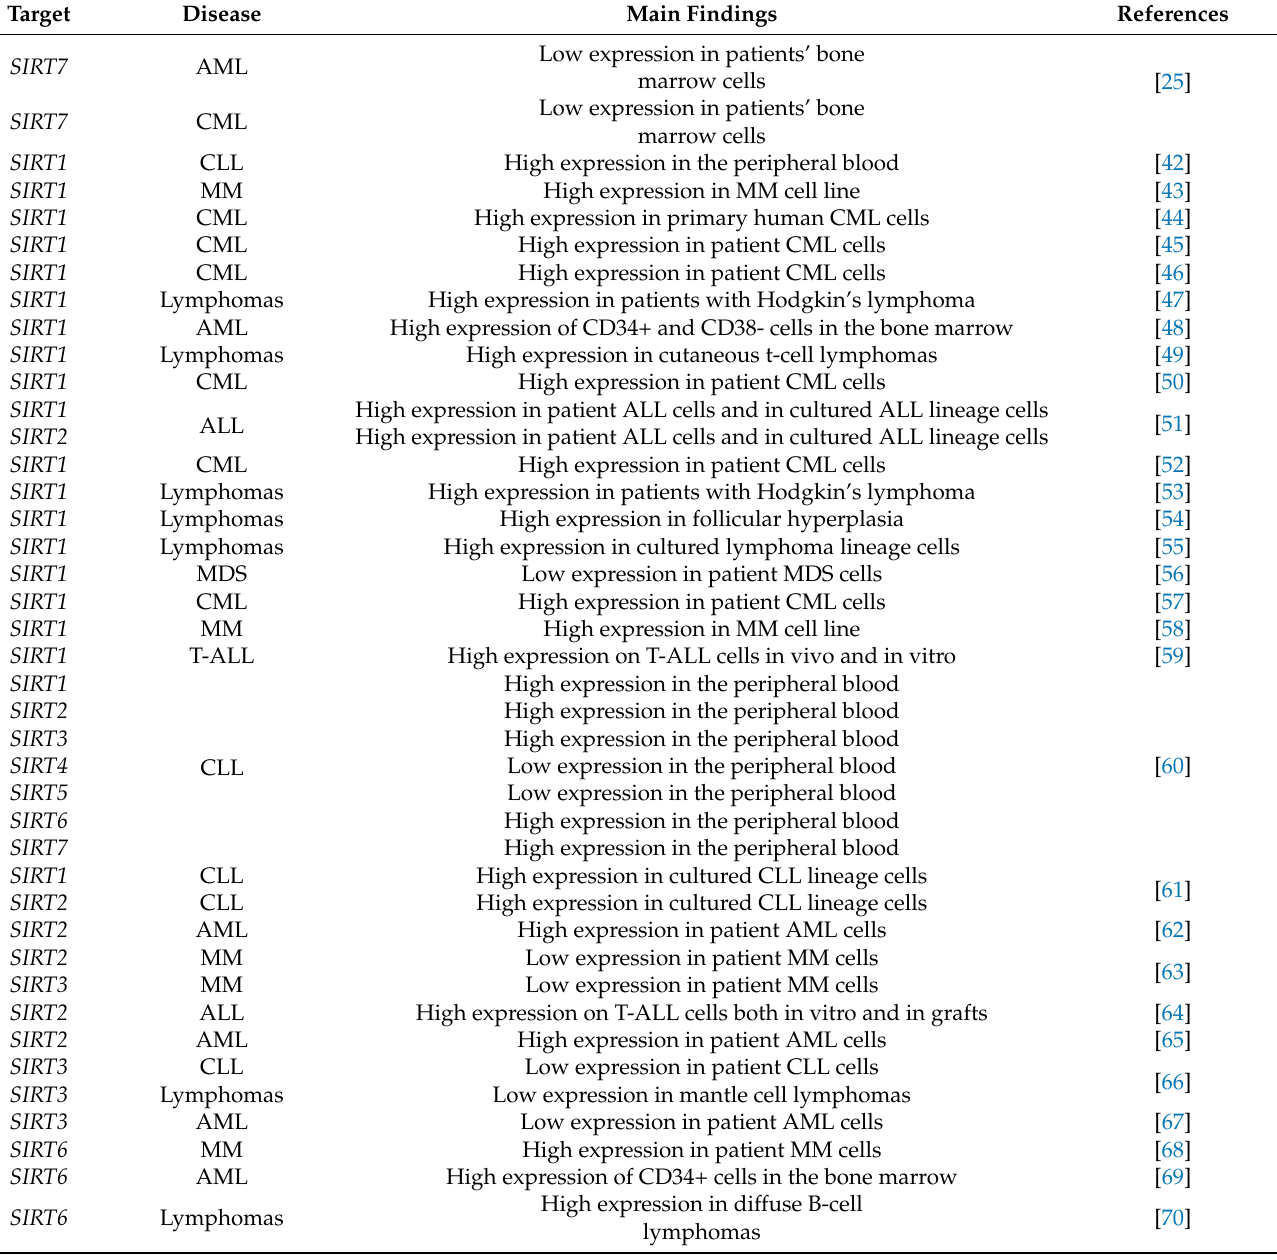
Table 1. Description of the SIRTs expression in oncohematological